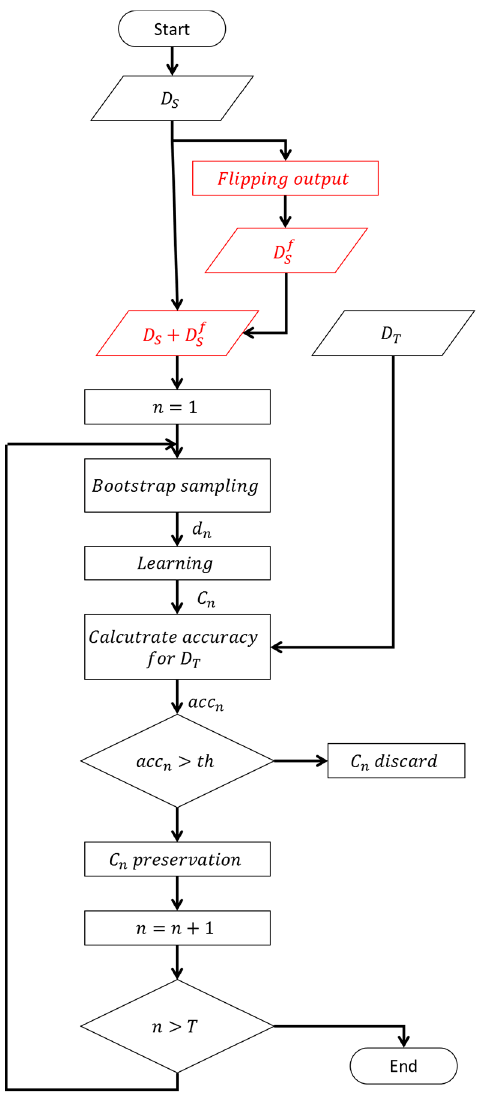
Figure 2. Flow chart of the proposed method.